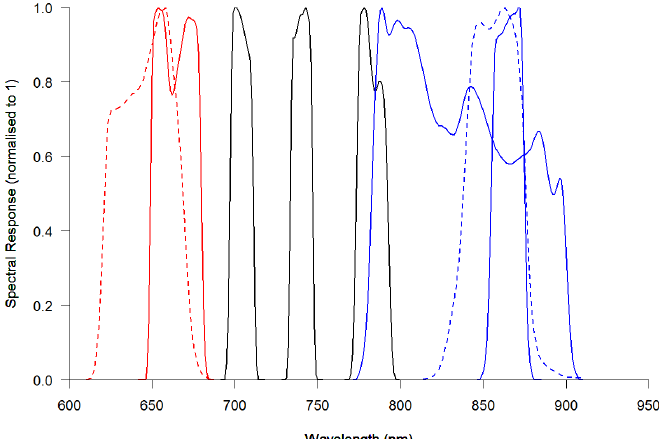
Figure 1. Spectral response functions for the Sentinel-2 MSI (solid, [1]) and MODIS (dashed, [23]) red to NIR wavelength bands. The MSI red-edge bands 5 (705 nm), band 6 (740 nm), and band 7 (783 nm) are shown in black. The MSI bands (in order of increasing central wavelength) are band 4 (665 nm), band 5 (705 nm), band 6 (740 nm), band 7 (783 nm), band 8 (842 nm), and band8A (865 nm). The MODIS red (645 nm) and NIR (858 nm) bands are shown by the dashed lines.